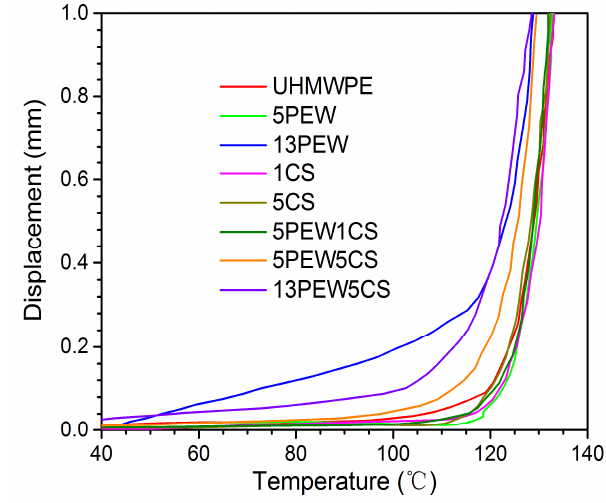
Figure 4. The Vicat softening temperature (VST) curves of UHMWPE with di ff erent contents of PEW and CS.